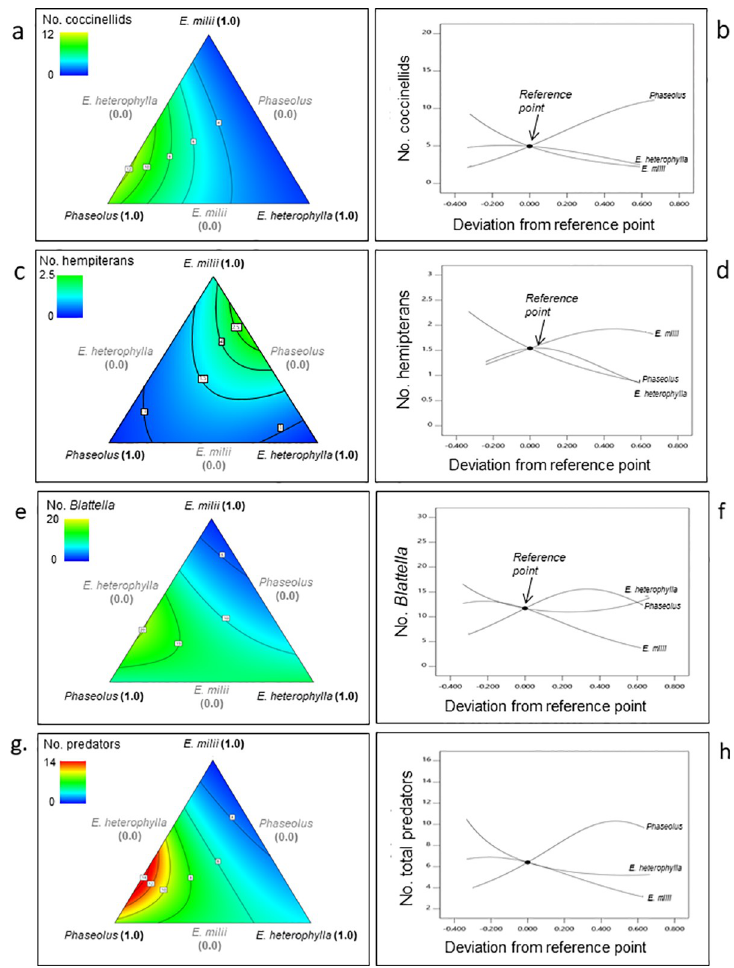
Fig 4. Response surface plots showing the influence of proportionality of plant species on the occurrence of insect predators in the Spring 2017 experiment. The 3-component mixture was composed of Euphorbia milii (crown-of- thorns), E . heterophylla (wild poinsettia), and Phaseolus lunatus (lima bean). a ) Contour plot of the number of coccinellids. b ) Trace plot of the effects of E . milii , P . lunatus , and E . heterophylla on the number of coccinellids. c ) Contour plot of the number of predatory hemipterans. d ) Trace plot of the effects of the E . milii , P . lunatus , and E . heterophylla on the number of predatory hemipterans. e) Contour plot of the number of B . asahinai . f ) Trace plot of the effects of the E . milii , P . lunatus , and E . heterophylla on the number of B . asahinai . g ) Contour plot of the number of all predators combined. g ) Trace plot of the effects of the E . milii , P . lunatus , and E . heterophylla on the number of all predators